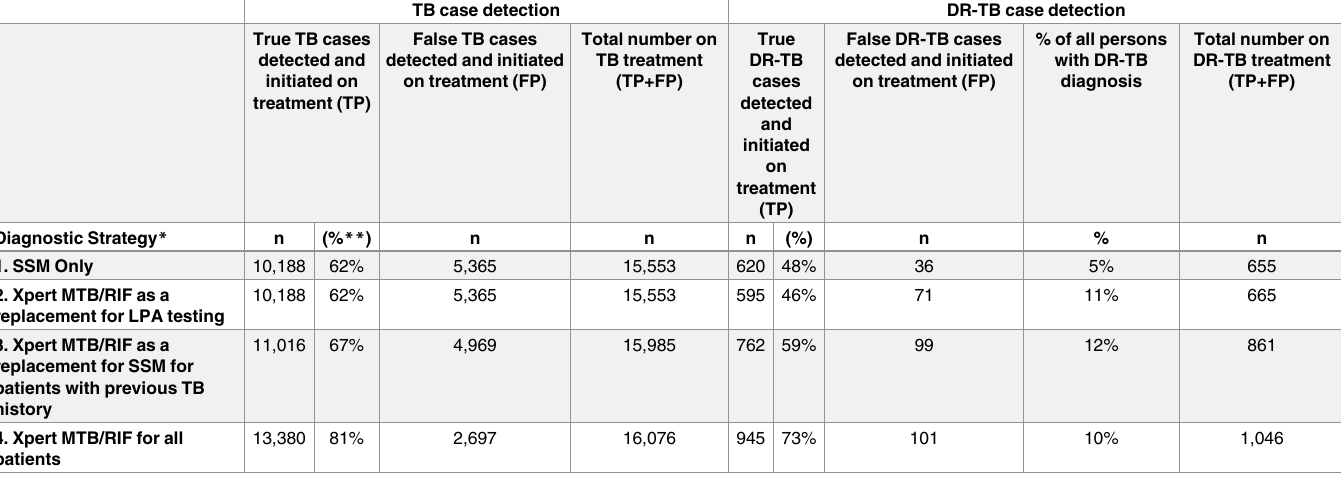
Table 2. TB and rifampicin resistant-TB cases detected and initiated on treatment by each of the 4 diagnostic strategies, in a cohort 100,000 persons. TB case detection DR-TB